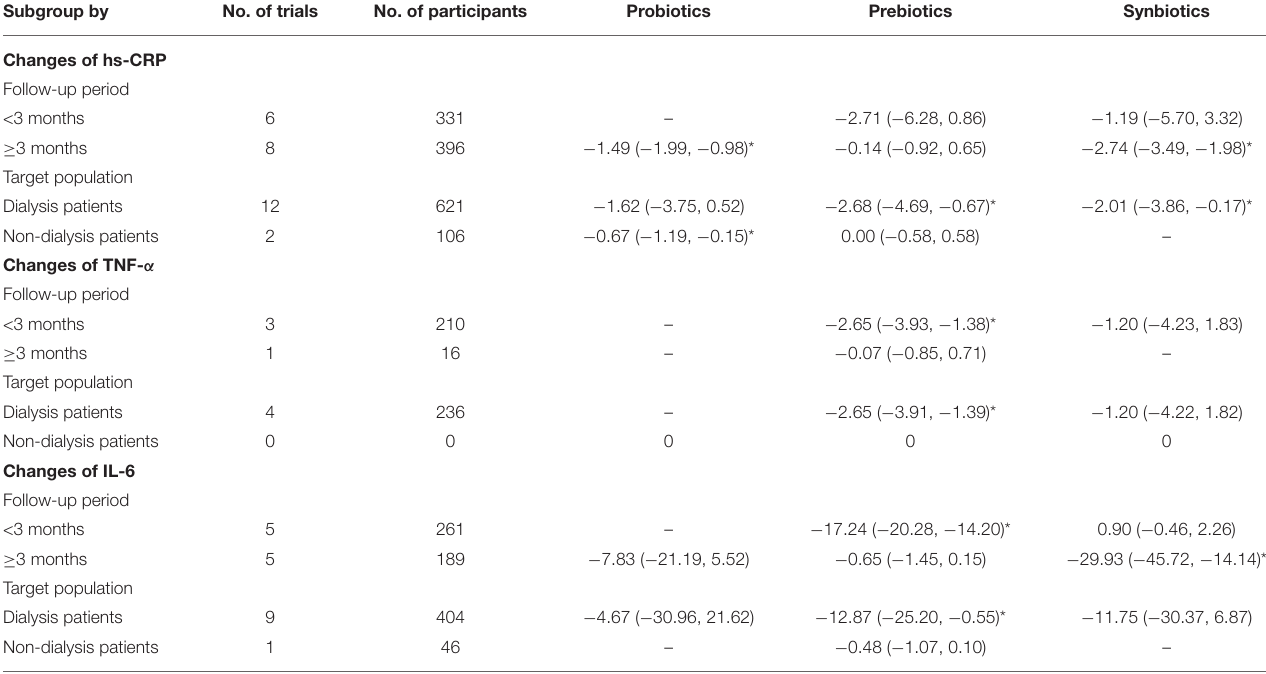
TABLE 4 | Subgroup analysis of inflammatory biomarkers. No. of trials No. of